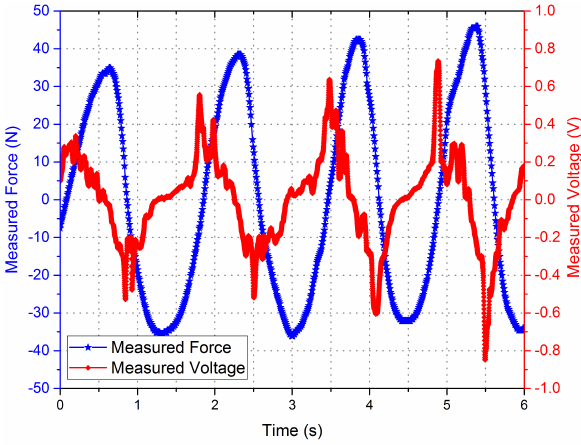
Figure 7. Measured force and the measured voltage curves with drive current = 0.01 A.